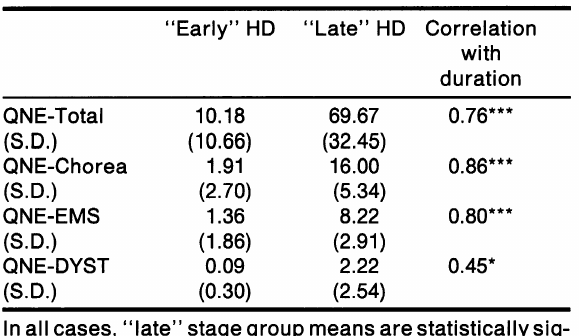
TABLE IV. ONE measures, group means and standard deviations (S.D.)